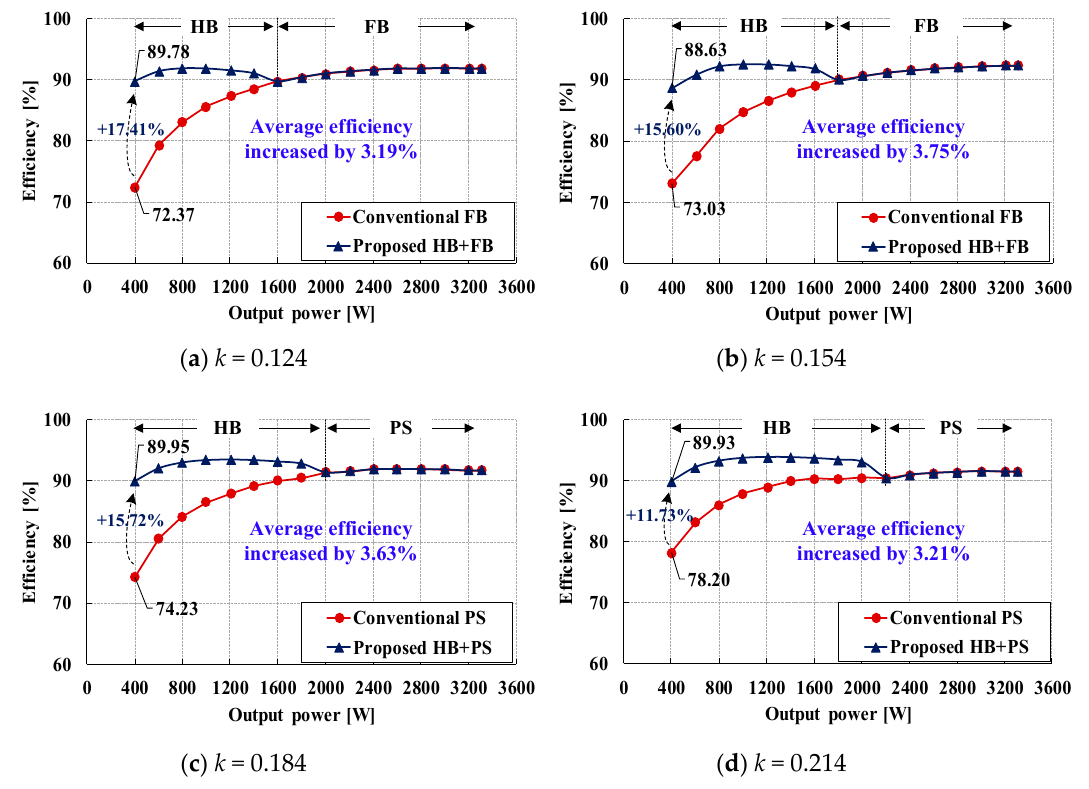
Figure 11. Efficiencies of the 3.3 kW IPT converter with respect to P batt for each k .